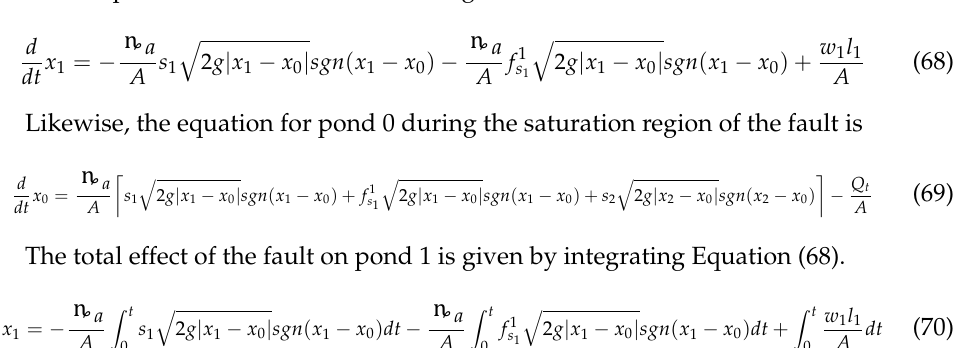
Figure 1. Three-pond hydraulic